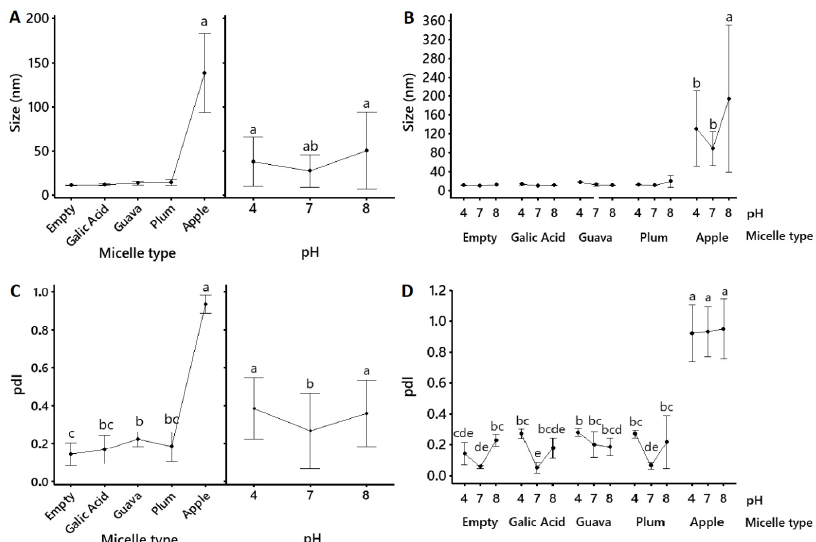
by a two ‐ sample t ‐ test or one ‐ way ANOVA and Tukey´s multiple comparison test (apple), and they are indicated by superscript letters ( p < 0.05) (Minitab v.19.1.1., USA).